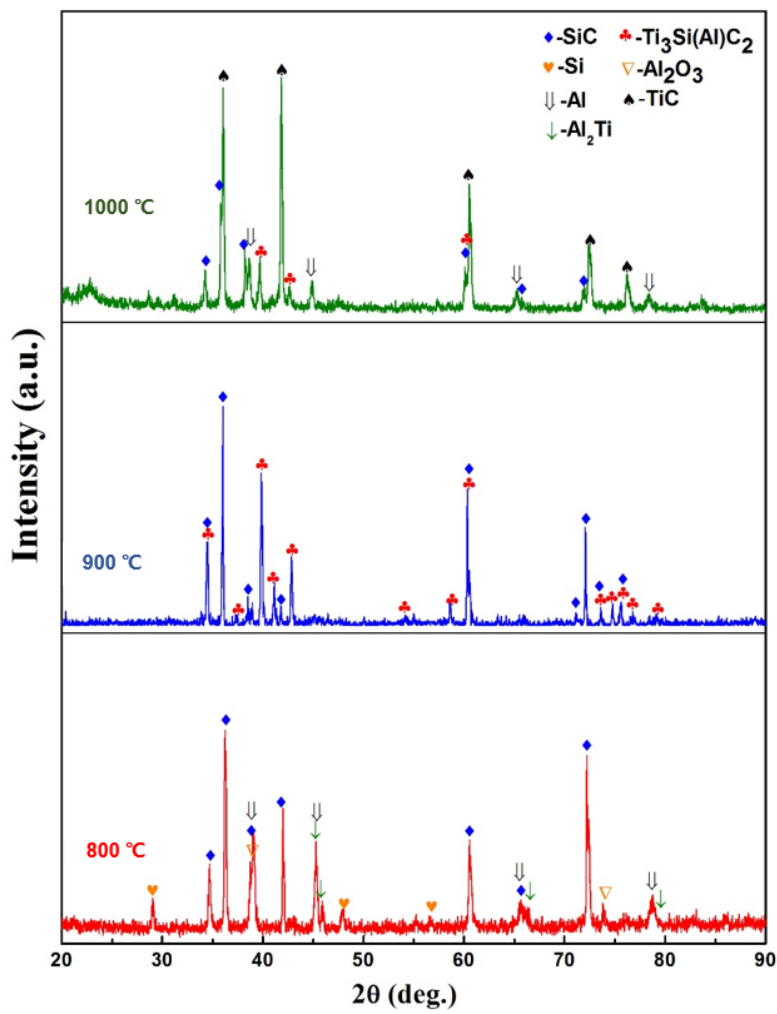
Figure 5. XRD patterns of SiC ceramics infiltrated at 800, 900, and 1000 °C for 6